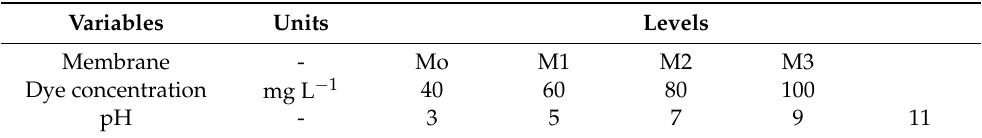
Table 2. Variables, experimental range and levels for the time independent ( t = 120 min) statisti- cal